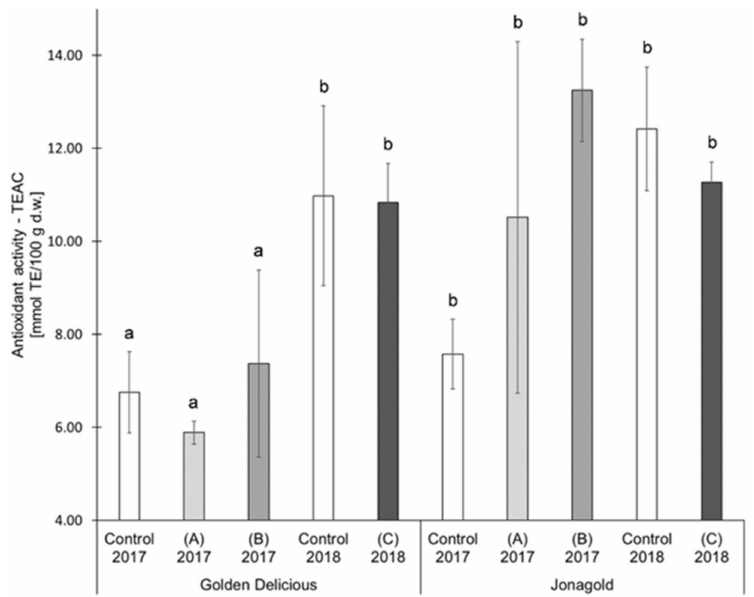
Figure 4. Results of the antioxidant activity (Trolox Equivalent Antioxidant Capacity Assay (TEAC) assay) in mmol TE / 100 g d.w. for the apple samples. Foliar Se application per hectare and meter canopy height: 0.15 kg as selenite (A), or selenate (B), 0.075 kg as selenate (C) ( n = 4). Di ff erent letters are significantly di ff erent ( p <